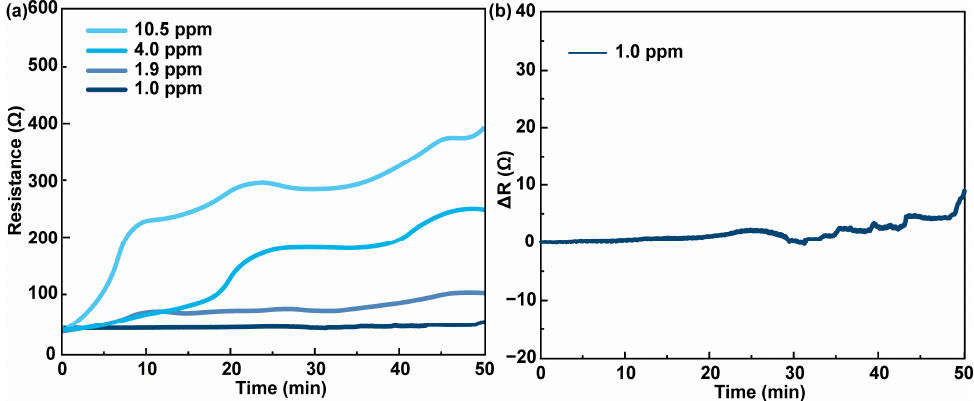
Figure 8. ( a ) Resistance-time curve of PEDOT film towards different concentrations of HPV and ( b ) resistance change-time curve of PEDOT film to 1.0 ppm HPV.